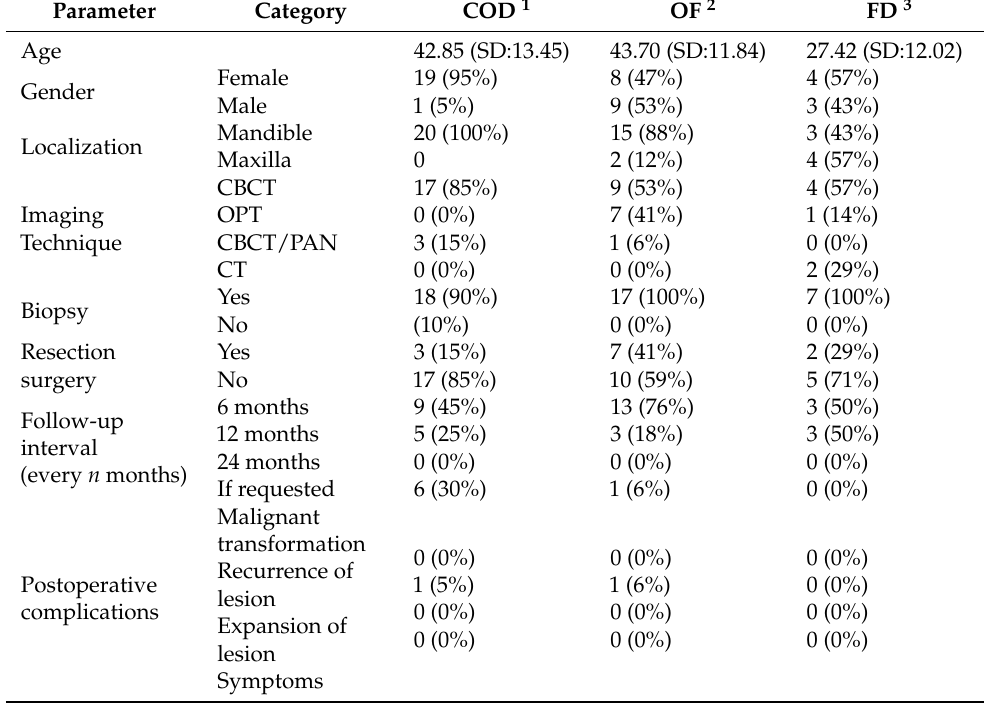
Table 2. Parameters for each type of fibro-osseous lesion.